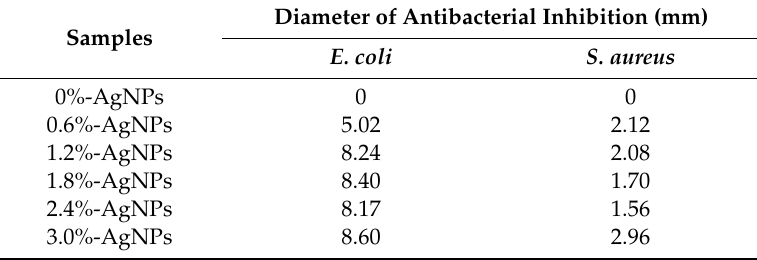
Figure 9. The antibacterial inhibition zone of composite nanofibers against E. coli and S. aureus. Table 4. The diameter of antibacterial inhibition zone of the FK / PVA / PEO composite nanofibers against E. coli and S. aureus .